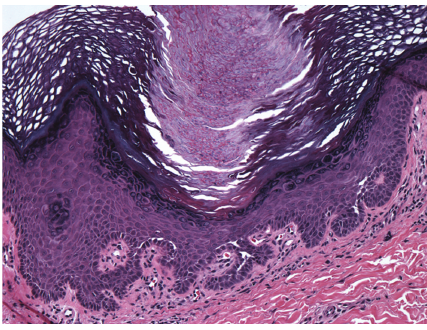
Figure 6: Histopathology demonstrating characteristic Darier’s pathology of suprabasal acantholysis and dyskeratosis.